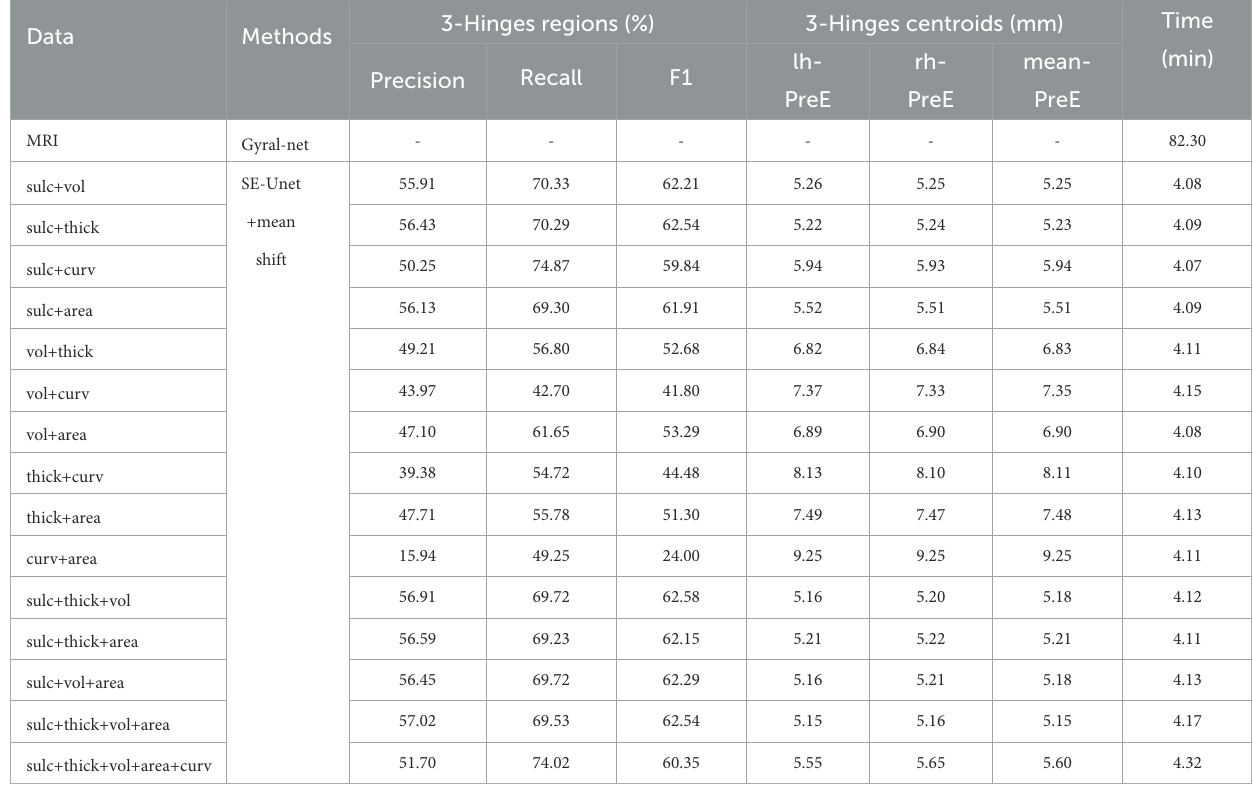
TABLE 3 The identification results of multi-features fusion.